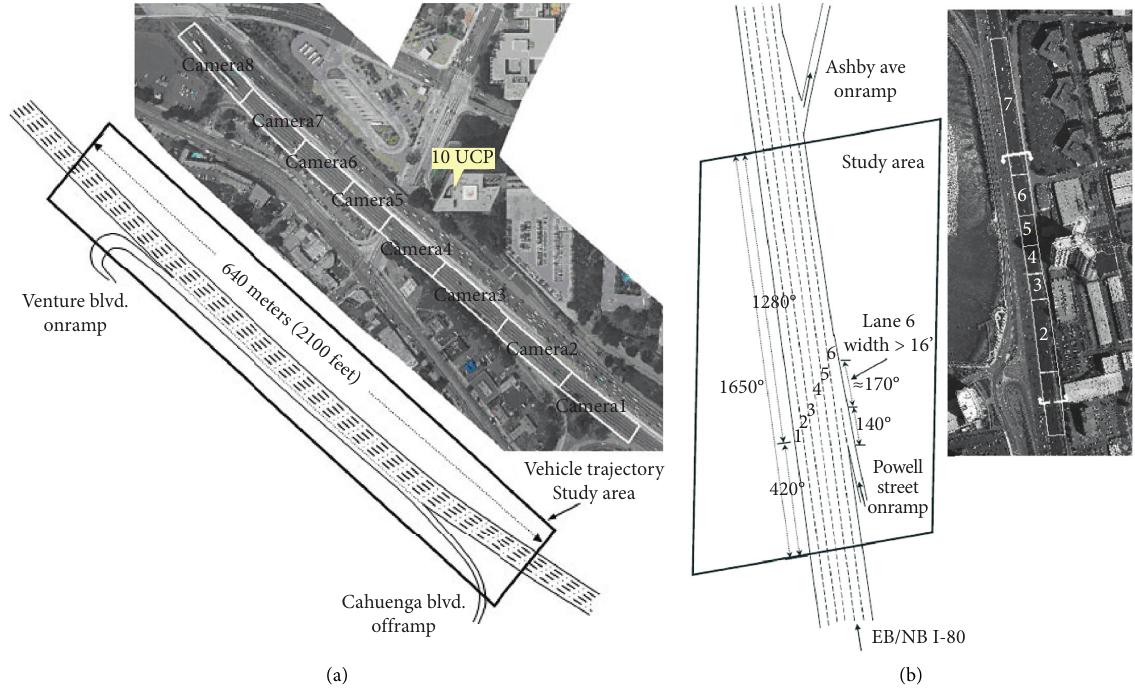
Figure 11: Layouts and top-down views of the sites used for the collection of the NGSIM: (a) US101; (b) I-80.